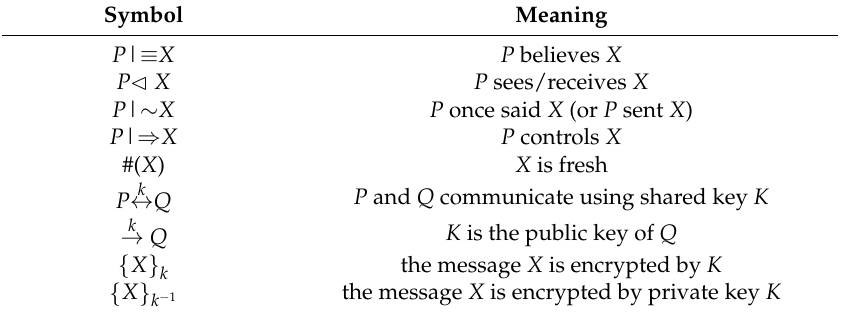
Table 9. Symbols of BAN logic.